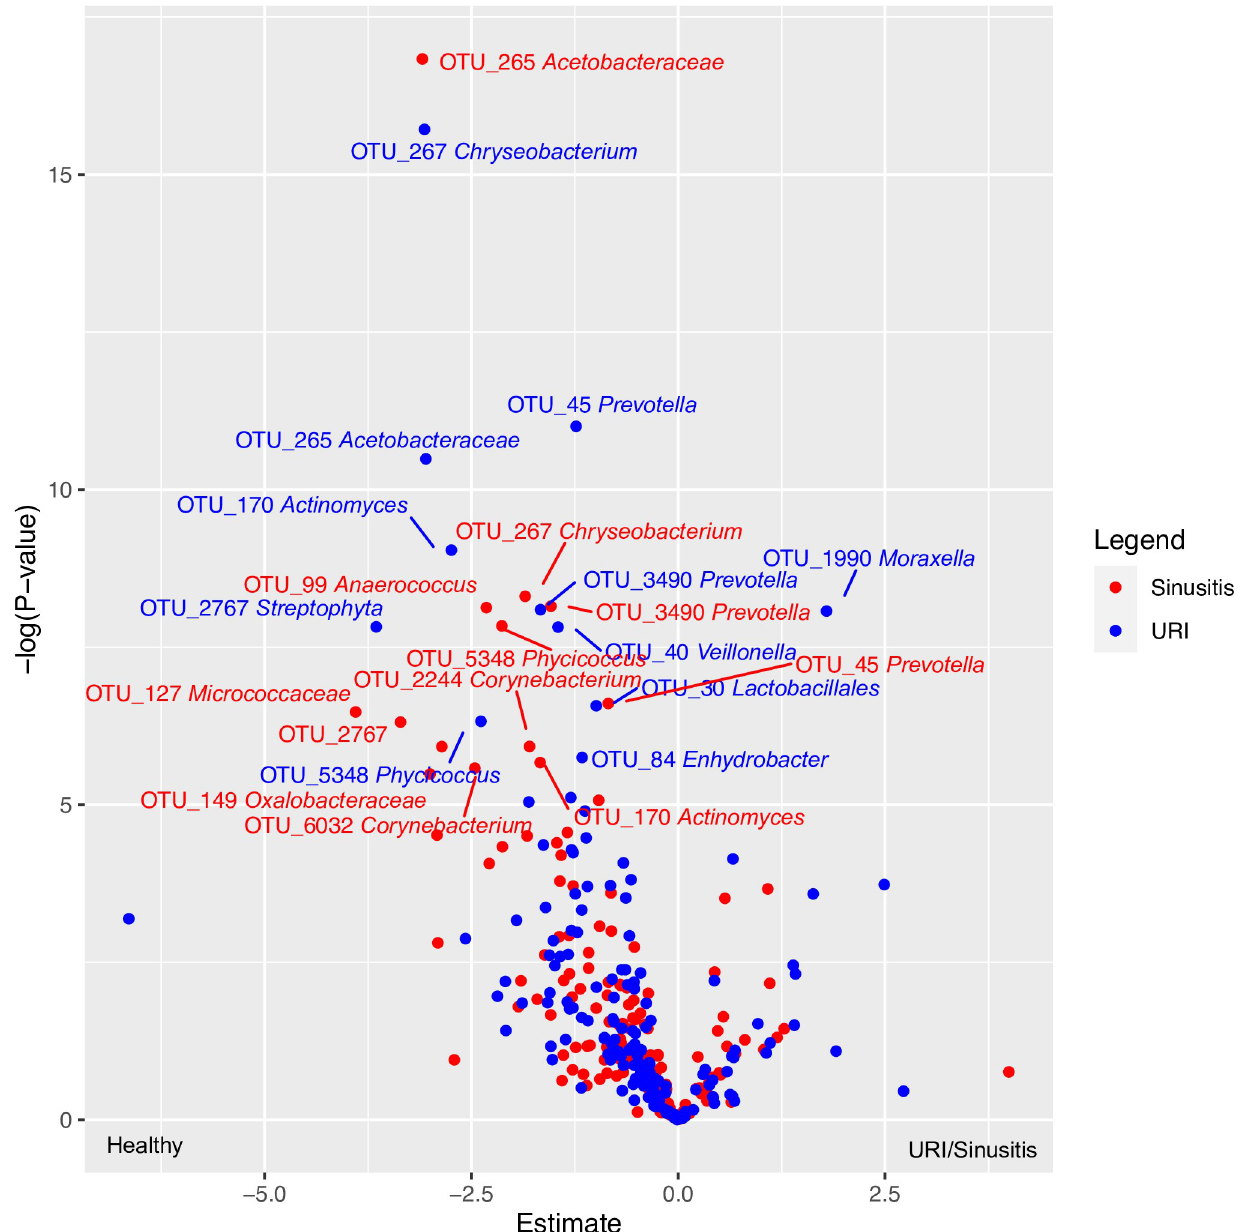
Fig 4. Several taxa are relatively depleted in the nasopharyngeal microbiota of children who develop Upper Respiratory Infection (URI) and Sinusitis, while a specific Moraxella taxon (OTU 1990) is relatively enriched in children who go on to develop URI, but not Sinusitis. Children who did not develop either URI or sinusitis are used as the comparison group. Red represents differential taxa in Sinusitis outcomes, while blue represents those taxa differential in URI outcomes (FDR p < 0.05). Abbreviations: Upper Respiratory Infection (URI); Operational Taxonomic Unit (OTU); False Discovery Rate